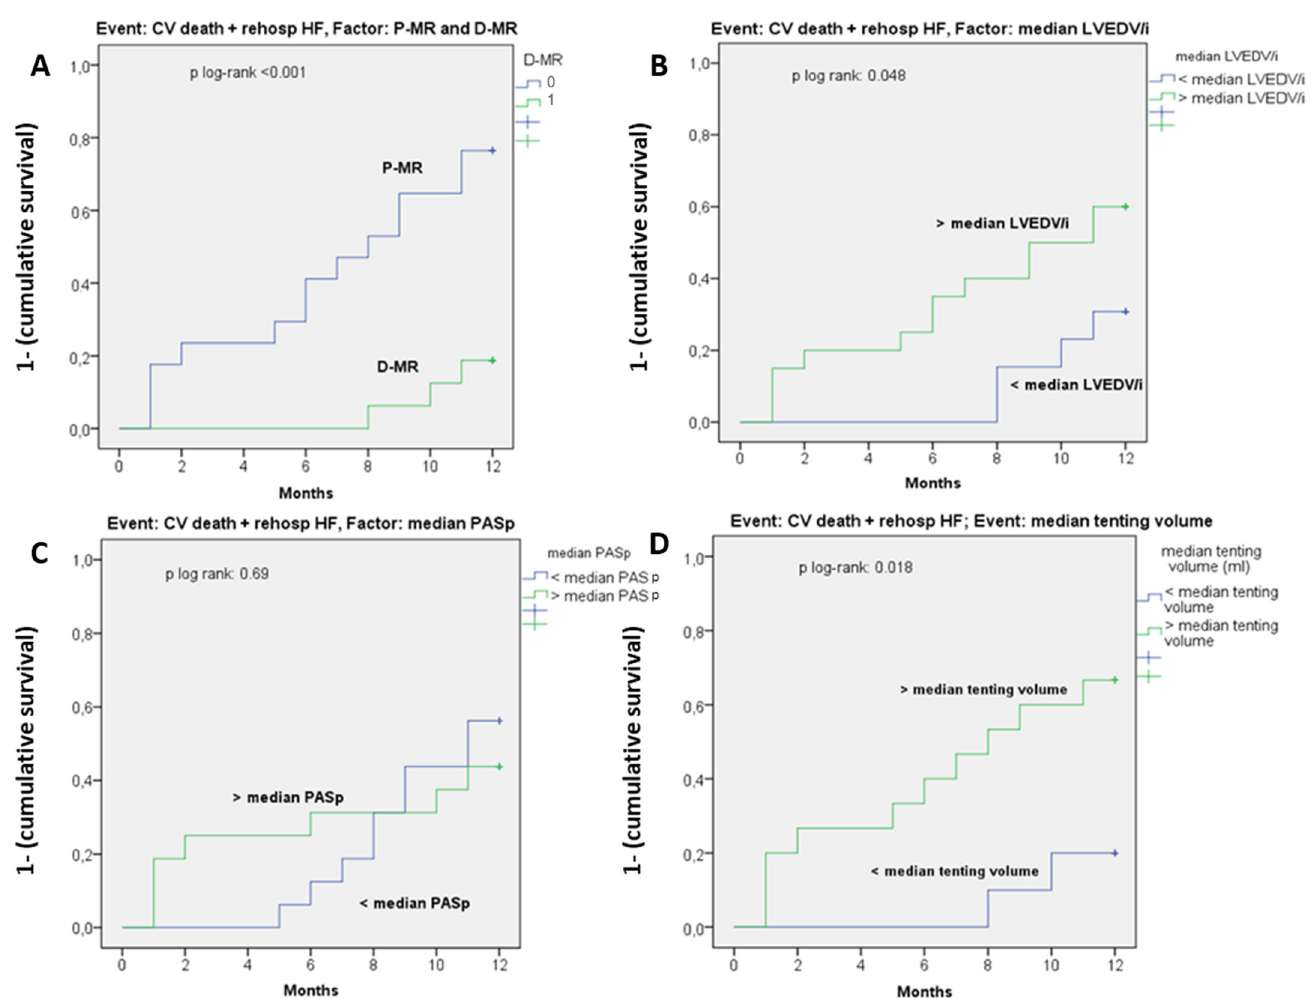
Figure 4. Survival analysis (Kaplan–Meier curves) for cardiovascular (CV) death and rehospitalization for HF. All curves show the 1-year event probability (expressed as 1—cumulative survival). ( A ) Factor: P-MR and D-MR status. ( B ) Factor: median value of LVEDV/I (mL/m 2 ). ( C ) Factor: median value of PASp (mmHg) ( D ) Factor: median value of tenting volume (mL).